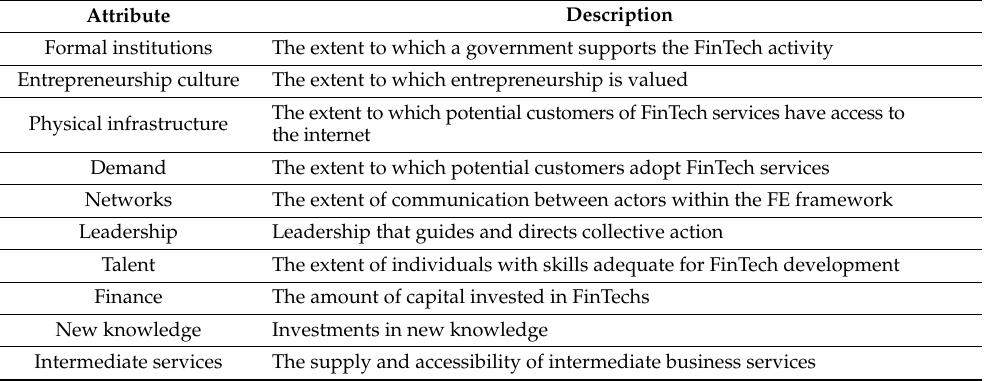
Table 2. Attributes of an